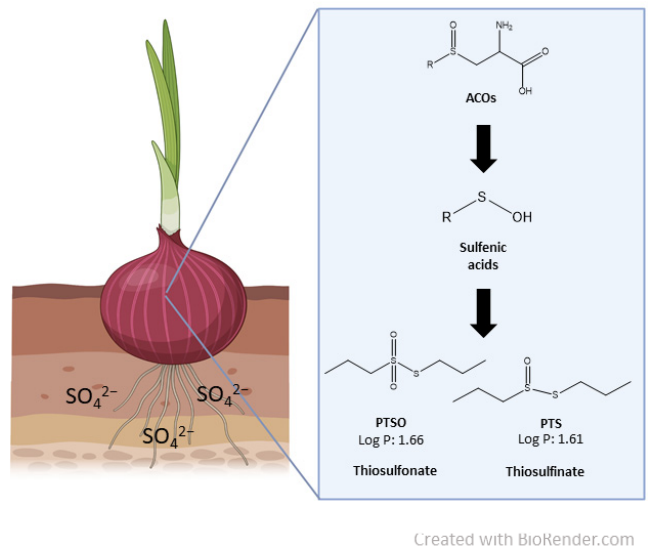
Figure 1. Scheme of the chemical structures and biochemical pathways of organosulfur compounds. ACOs: Alk(en)yl cysteine sulfoxides.